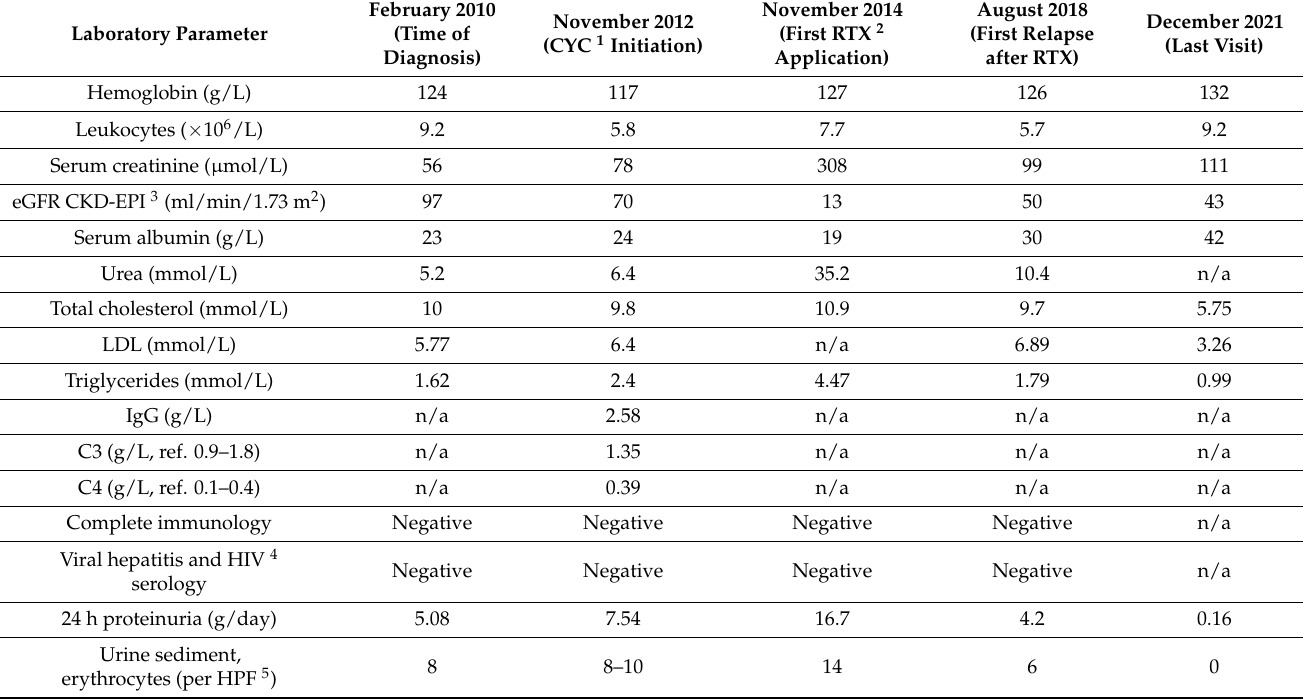
Table 1. Important laboratory parameters during treatment with RTX in case of